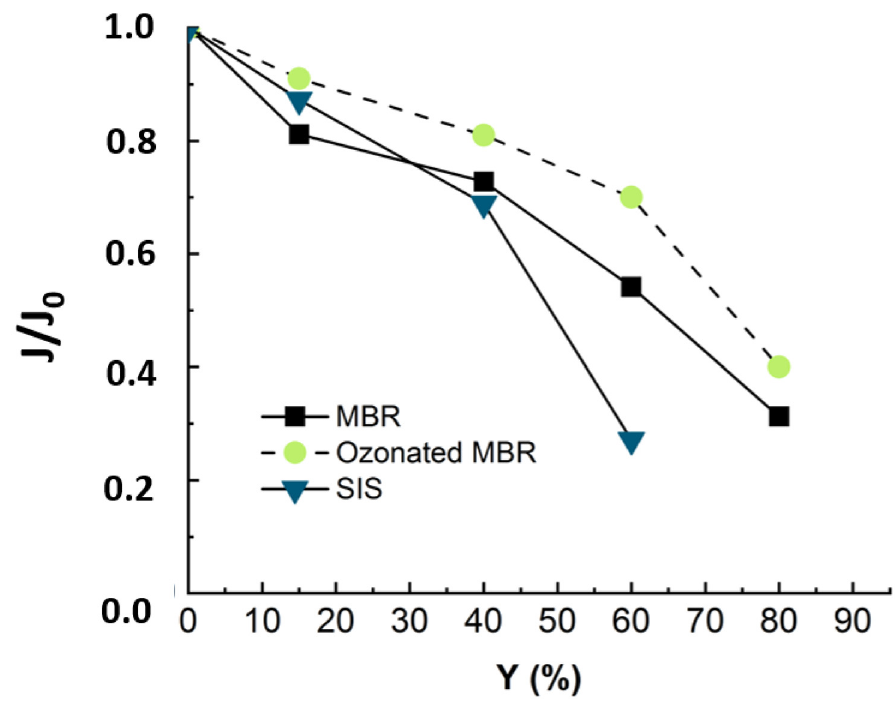
Figure 9. Flux evolution in NF experiment applied to synthetic ionic solution (duration of the experiment = 18 h) and non-ozonated (duration of the experiment = 24 h) and ozonated MBR real effluent matrixes (duration of the experiment = 24 h). Ozonation reaction time = 30 min, T ◦ = 20 ◦ C, Vreactor = 3 L, Vstir = 400 rpm, [O 3 ]gas = 5 gO 3 /Nm 3 TMP = 10 bars, J 0 -MBR = 53 L · m − 2 · h − 1